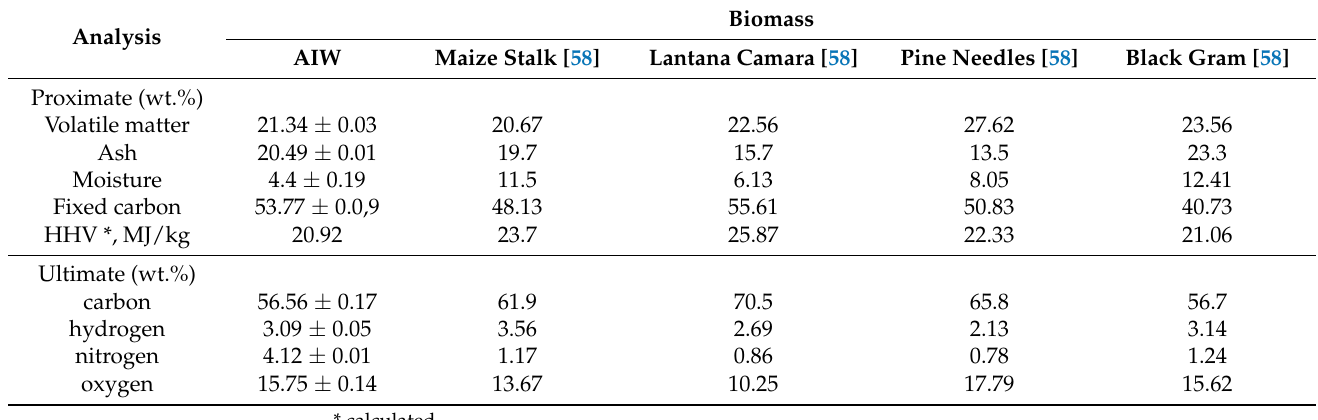
Table 4. The results of the proximate and ultimate analyses for biomass biochars.